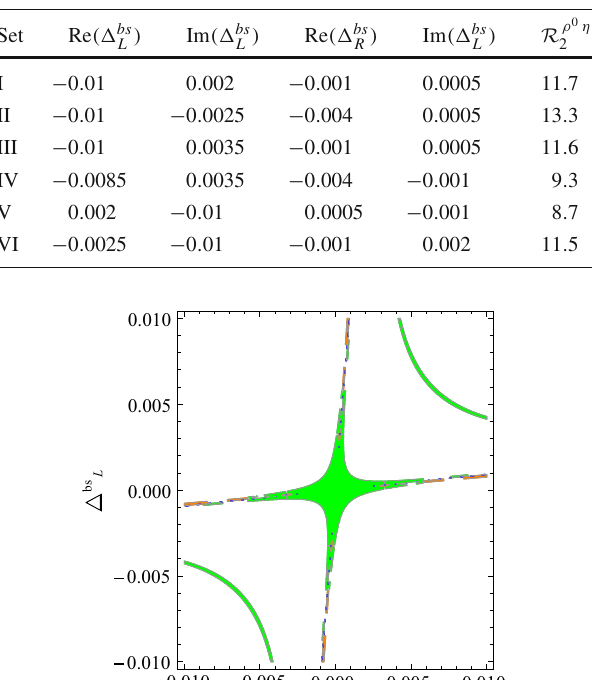
Table 6 Predictions for R